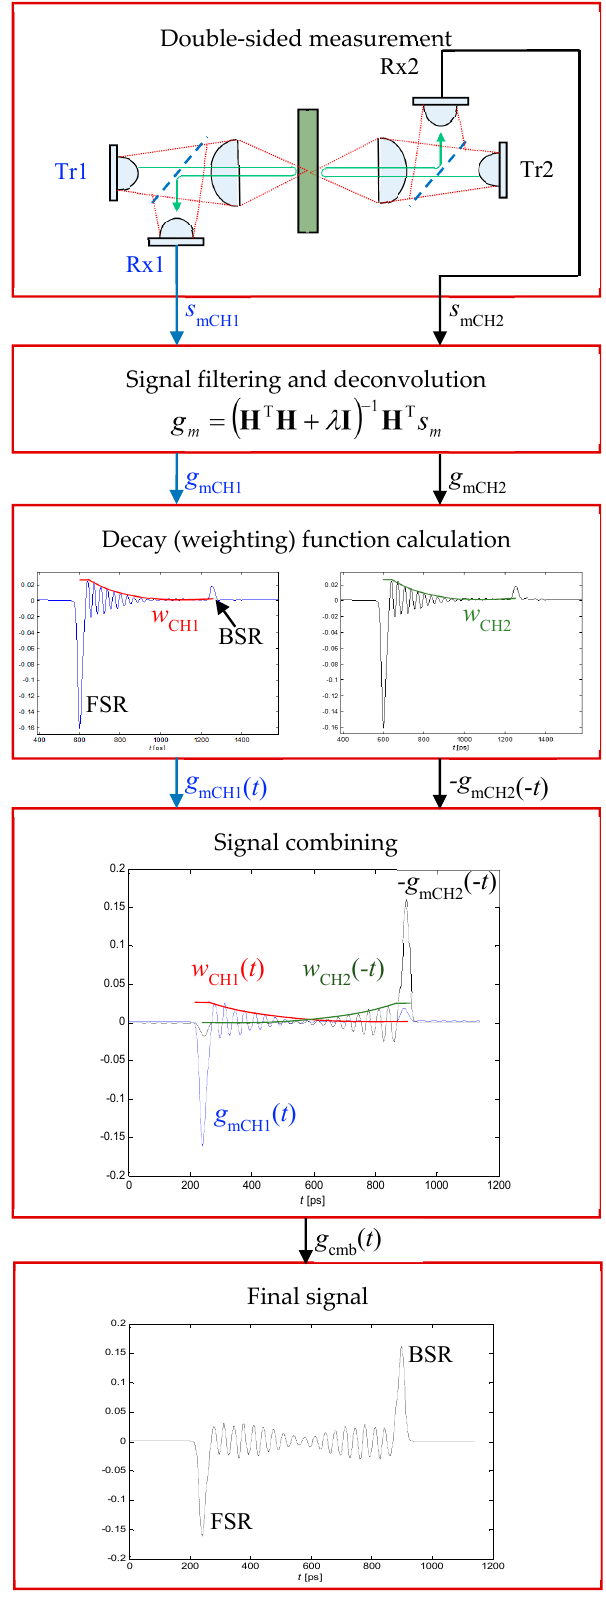
Figure 7. An algorithm of double-sided terahertz inspection of a layered structures.